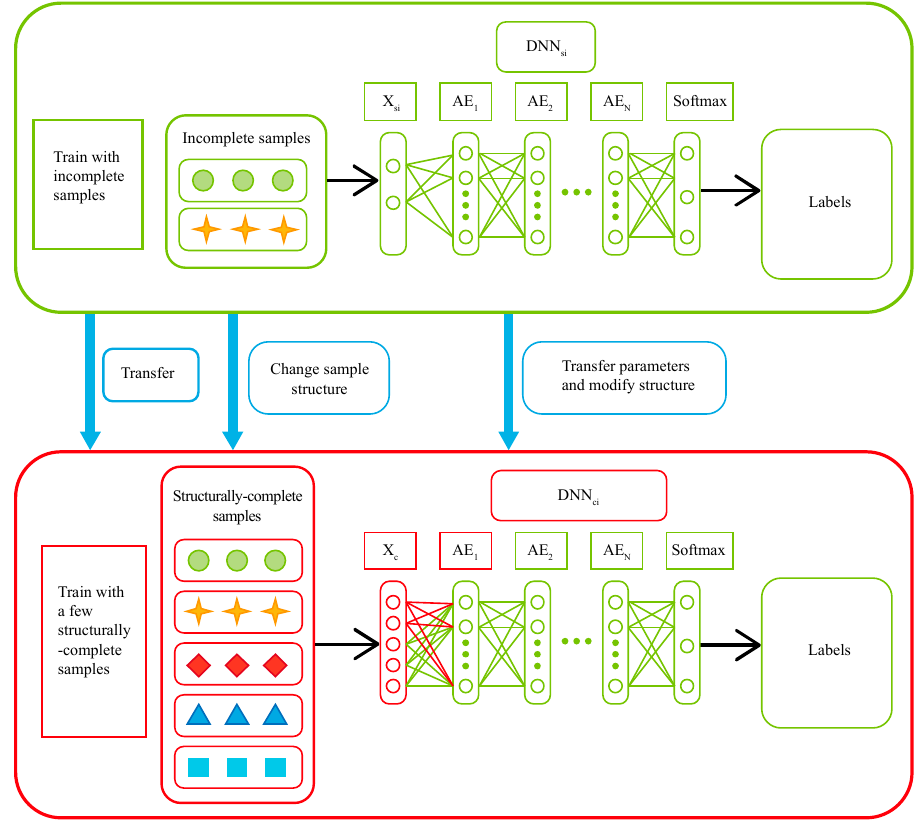
Figure 3. The transfer process of fault diagnosis model for multi-rate sampling.